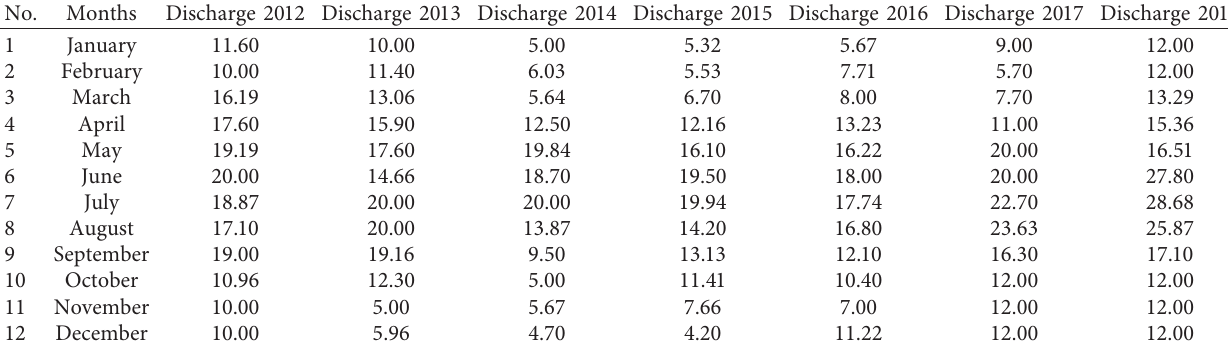
Table 6: Available discharge m 3 /sec at the head of the project